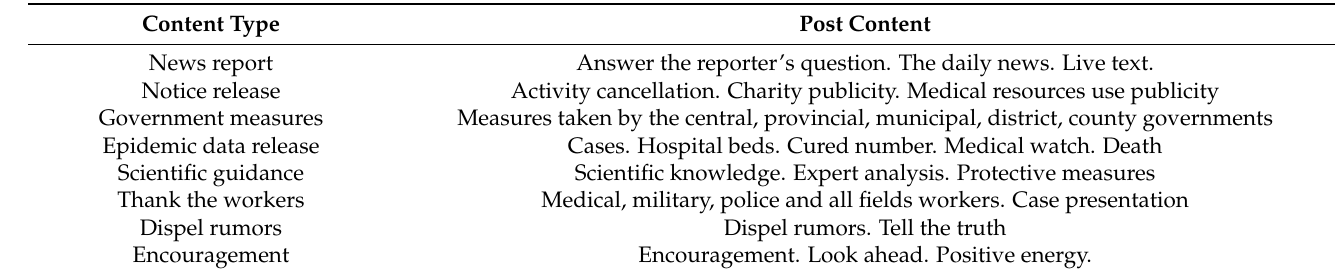
Table 1. Content types.